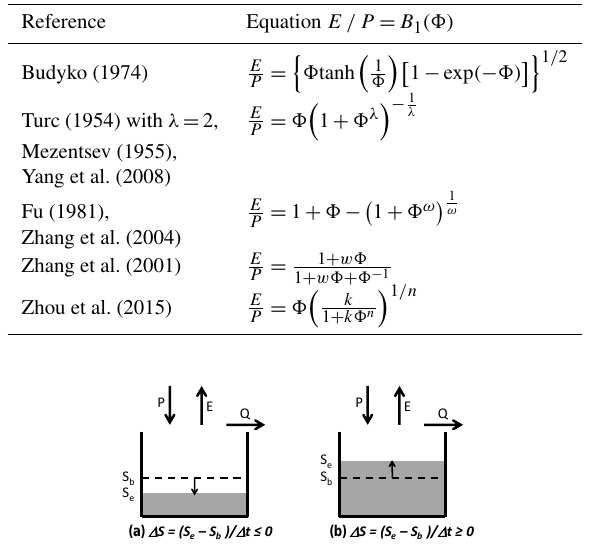
Figure 1. Representation of the change in soil water storage (cid:49)S = ( S e − S b ) /(cid:49)t for the two cases considered in the paper: (cid:49)S ≤ 0 and (cid:49)S ≥ 0. S b and S e are, respectively, the storage at the beginning and the end of the time period (cid:49)t